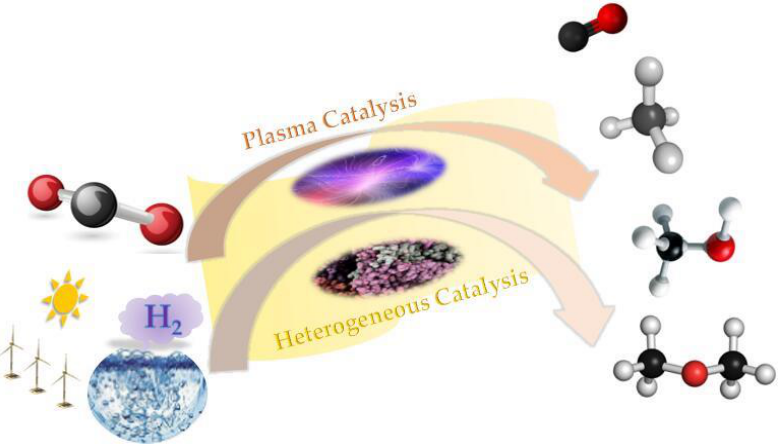
Figure 2. Catalytic hydrogenation of carbon dioxide.